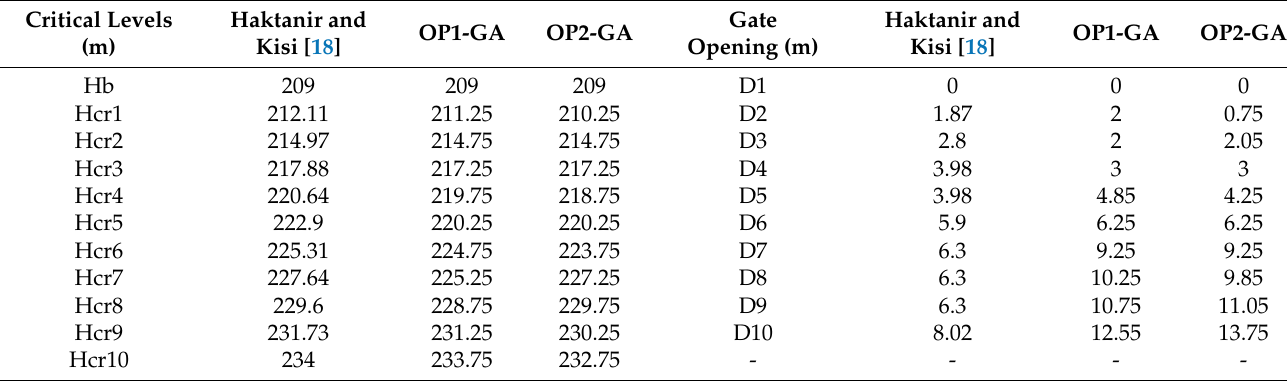
Figure 2. Flood hydrographs of the Karkheh reservoir (adapted from consulting engineering company of Mahab Ghods). Table 2. Critical levels and gate opening—Karkheh dam ( n =